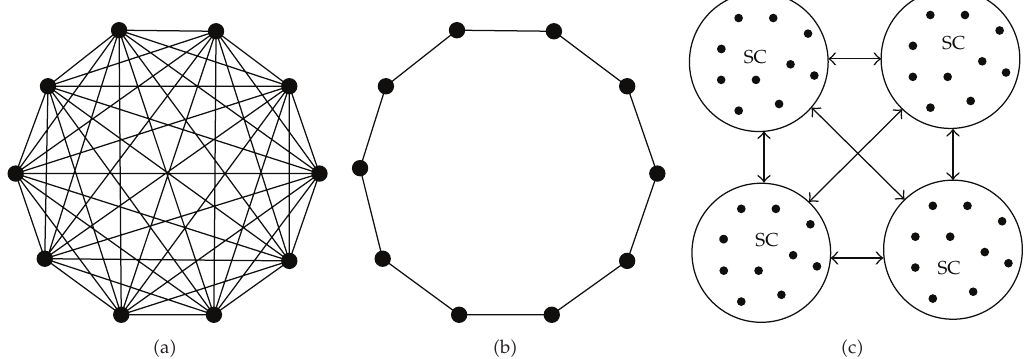
Figure 1: (cid:2) a (cid:3) Global neighborhood; (cid:2) b (cid:3) local neighborhood; (cid:2) c (cid:3) the proposed algorithm